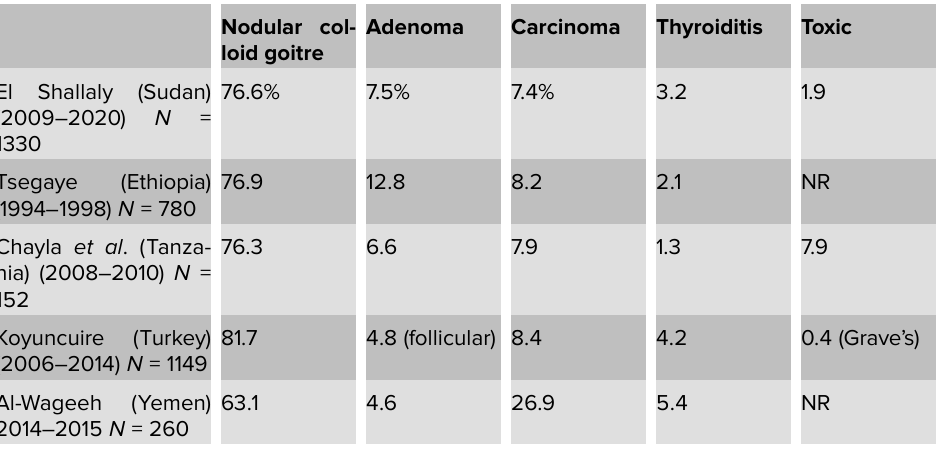
Table 3: Comparison pattern of thyroid disease.